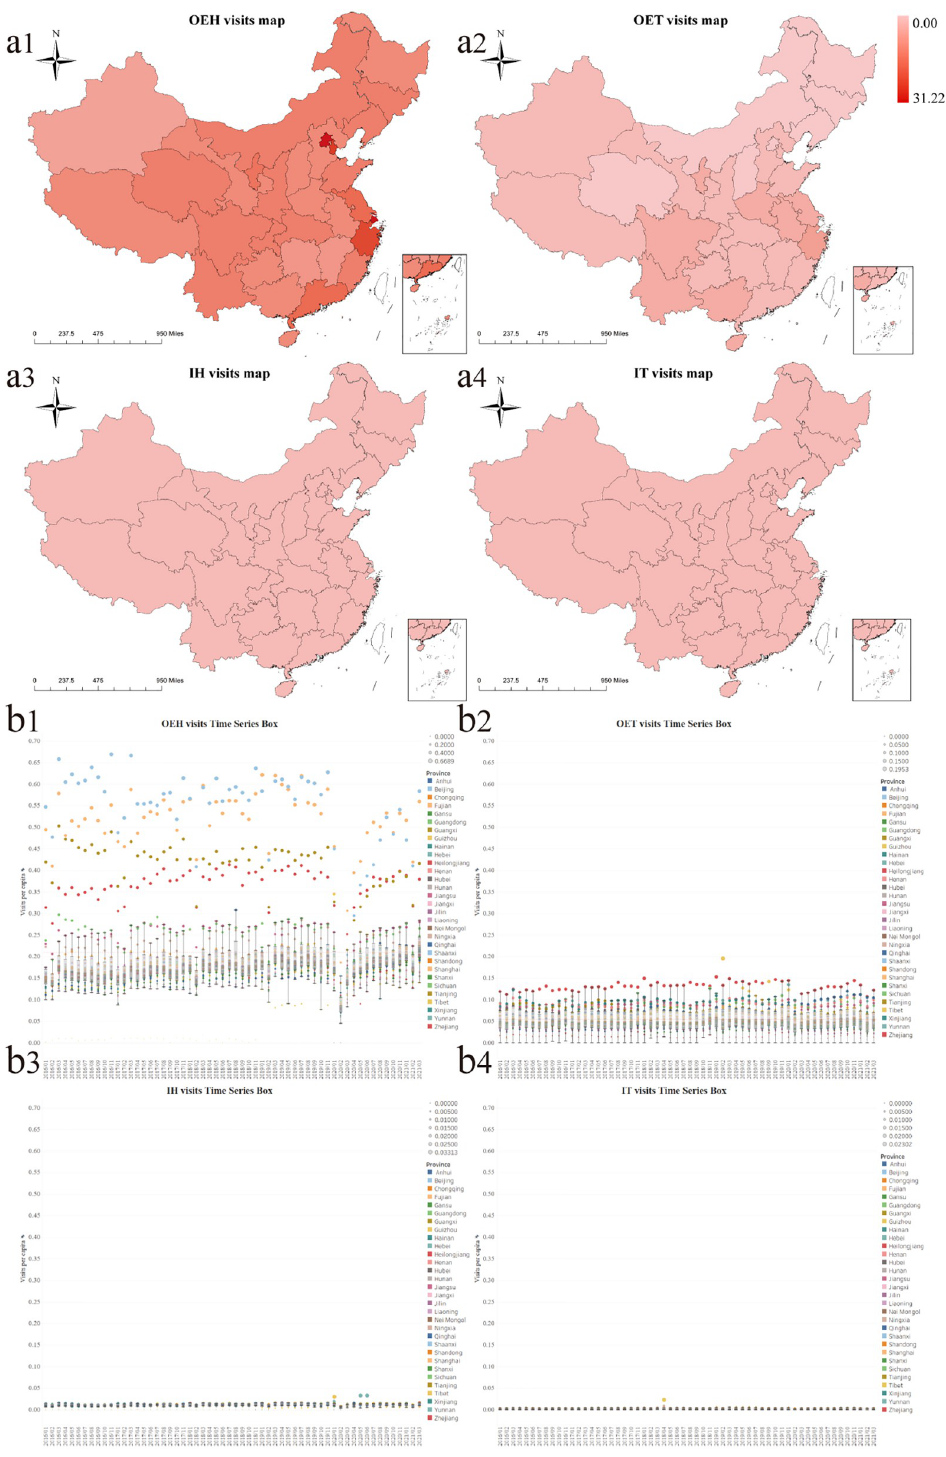
Fig 1. Four types of health services utilization per capita with their regional difference in mainland China. (a1, a2, a3, a4) These panels show the sum of visits per capita in four healthcare settings in mainland China from January 2016 to March 2021. They represent the number of OEH visits per capita, OET visits per capita, IH visits per capita, and IT visits per capita, respectively. Each color block reflects the visits per capita of each province. (b1, b2, b3, b4) These panels show actual monthly visits per capita in four healthcare settings of 31 provinces in mainland China